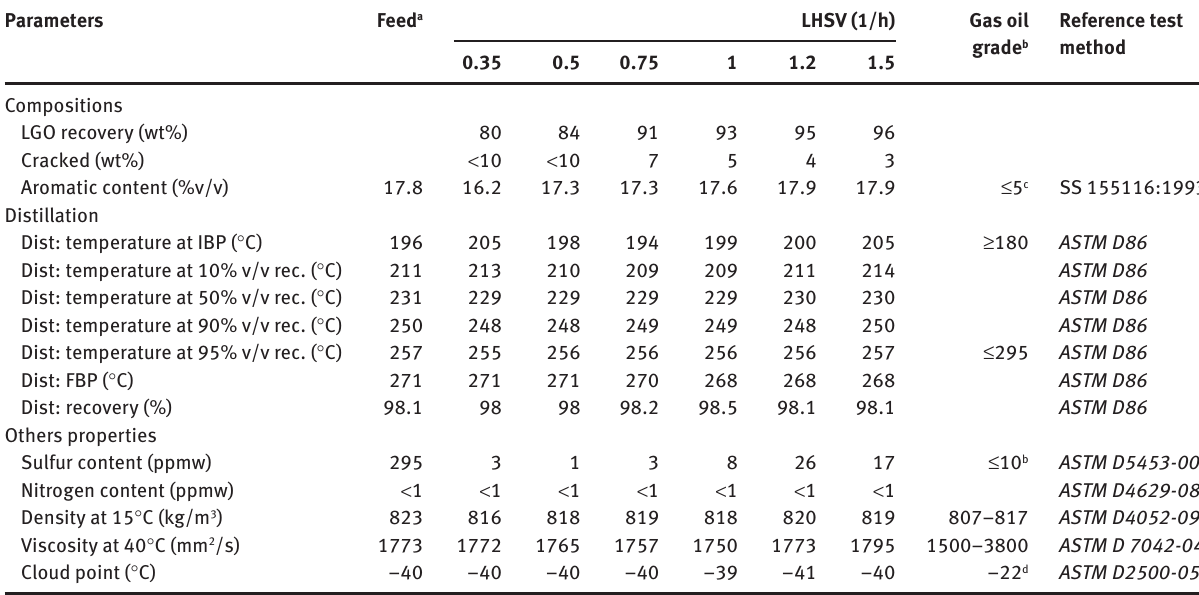
Table 2: Physicochemical properties of hydroprocessed light gas oil (LGO) at 5 MPa pressure.